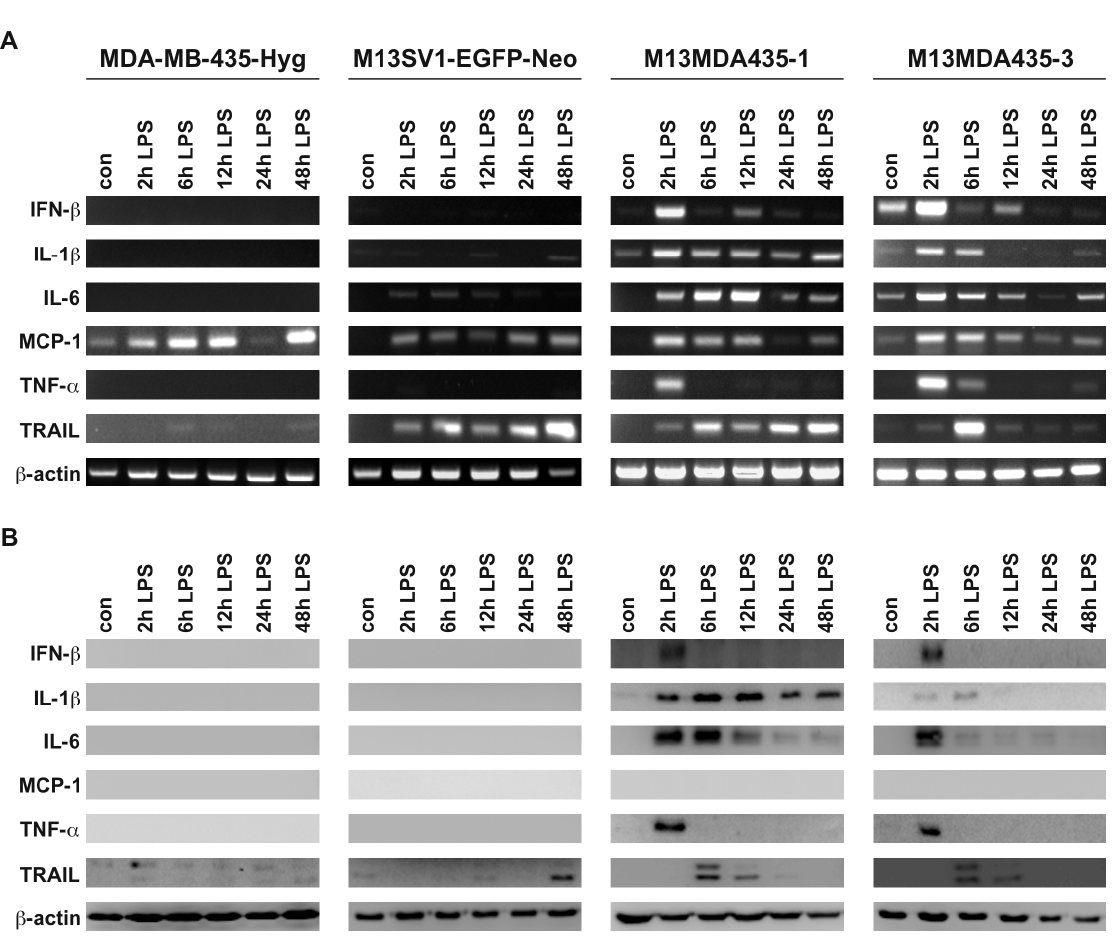
Figure 2. RT-PCR and Western blot analysis of target genes expressed in response to LPS stimulation. ( A ) RT-PCR data ( B ) Western blot data. All cell lines were treated with 100 ng/mL LPS for up to 48 h. Results show that the cell lines responded uniquely to LPS stimulation, which particularly applies for protein translation. Whereas in M13MDA435-1 and -3 hybrid cells most of the transcribed genes are expressed as proteins, protein expression is lacking in parental cells, which is putatively attributed to miRNA or lncRNA dependent mechanisms. Shown are representative RT-PCR and Western Blot data of three independent experiments.